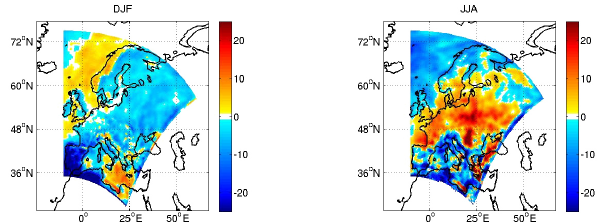
Figure 9. The difference in the vertically integrated cloud water in the MOD simulation compared to the CTRL simulation expressed as a percentage over the winter (DJF) and summer (JJA) months.